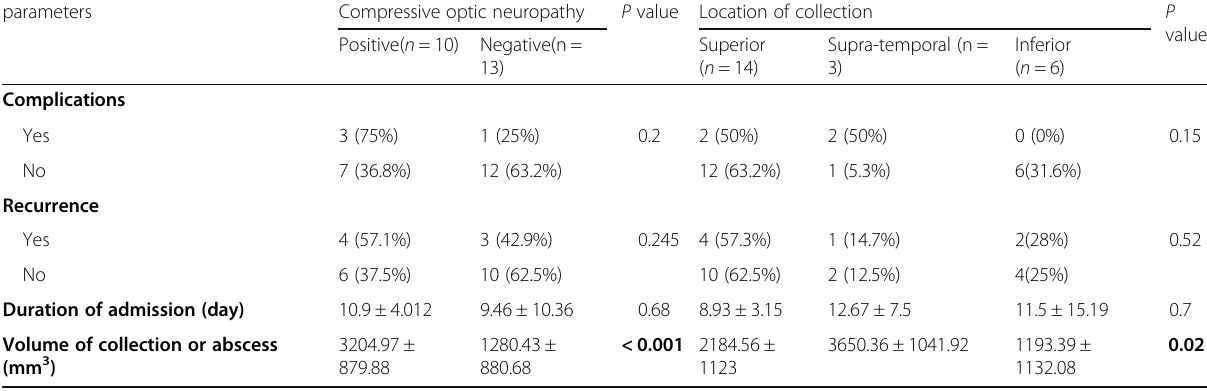
Table 4 Compression of complications, recurrence, duration of admission, and volume of abscess in patients with and without compressive optic neuropathy and in different locations